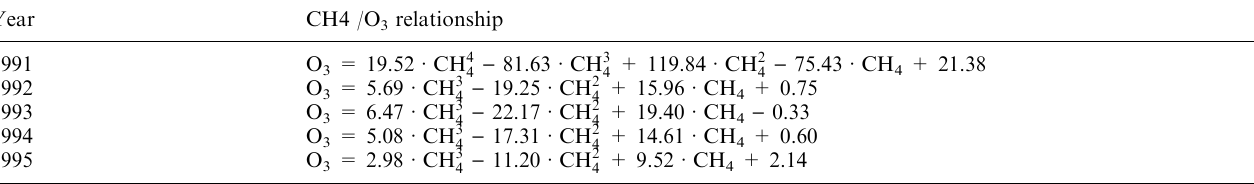
The empirical CH /O relation (for O and CH in ppmv) from 4 3 3 4 early vortex measurements for the five winters considered (based on version 18 HALOE data). The relations for 1991 and 1992 are